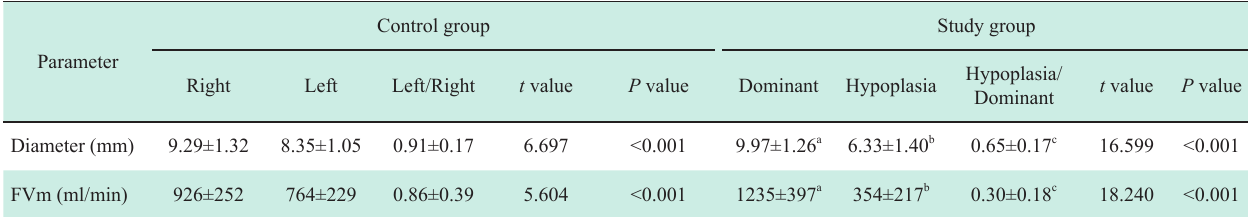
Table 1 Bilateral J1 diameter and blood flow volume of the two groups